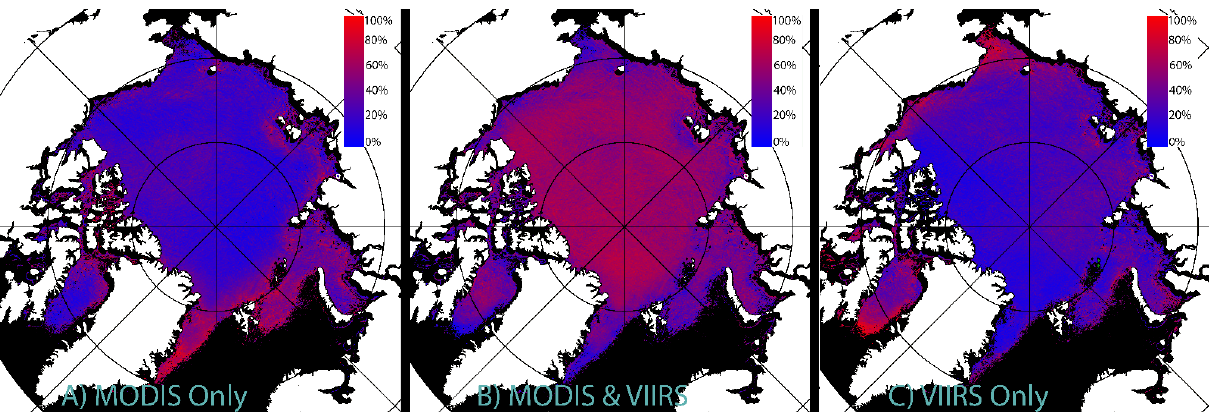
Figure 11. Lead detections from November 2017 through April 2022. Panel ( A ) shows the percentage of lead detections that are unique to MODIS, Panel ( B ) shows the percentage of lead detections that are co-located between MODIS and VIIRS, and Panel ( C ) shows the percentage of lead detections that are unique to VIIRS.